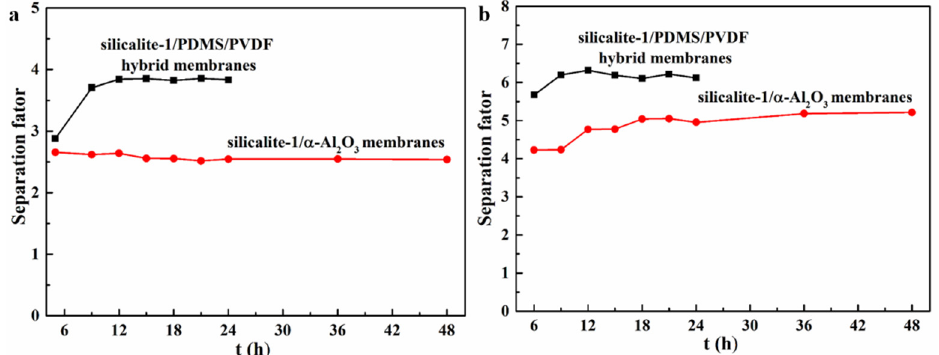
1/PDMS/PVDF hybrid membranes in single − isomer solutions: ( a ) p/o − DCB; and ( b ) p/m − DCB.